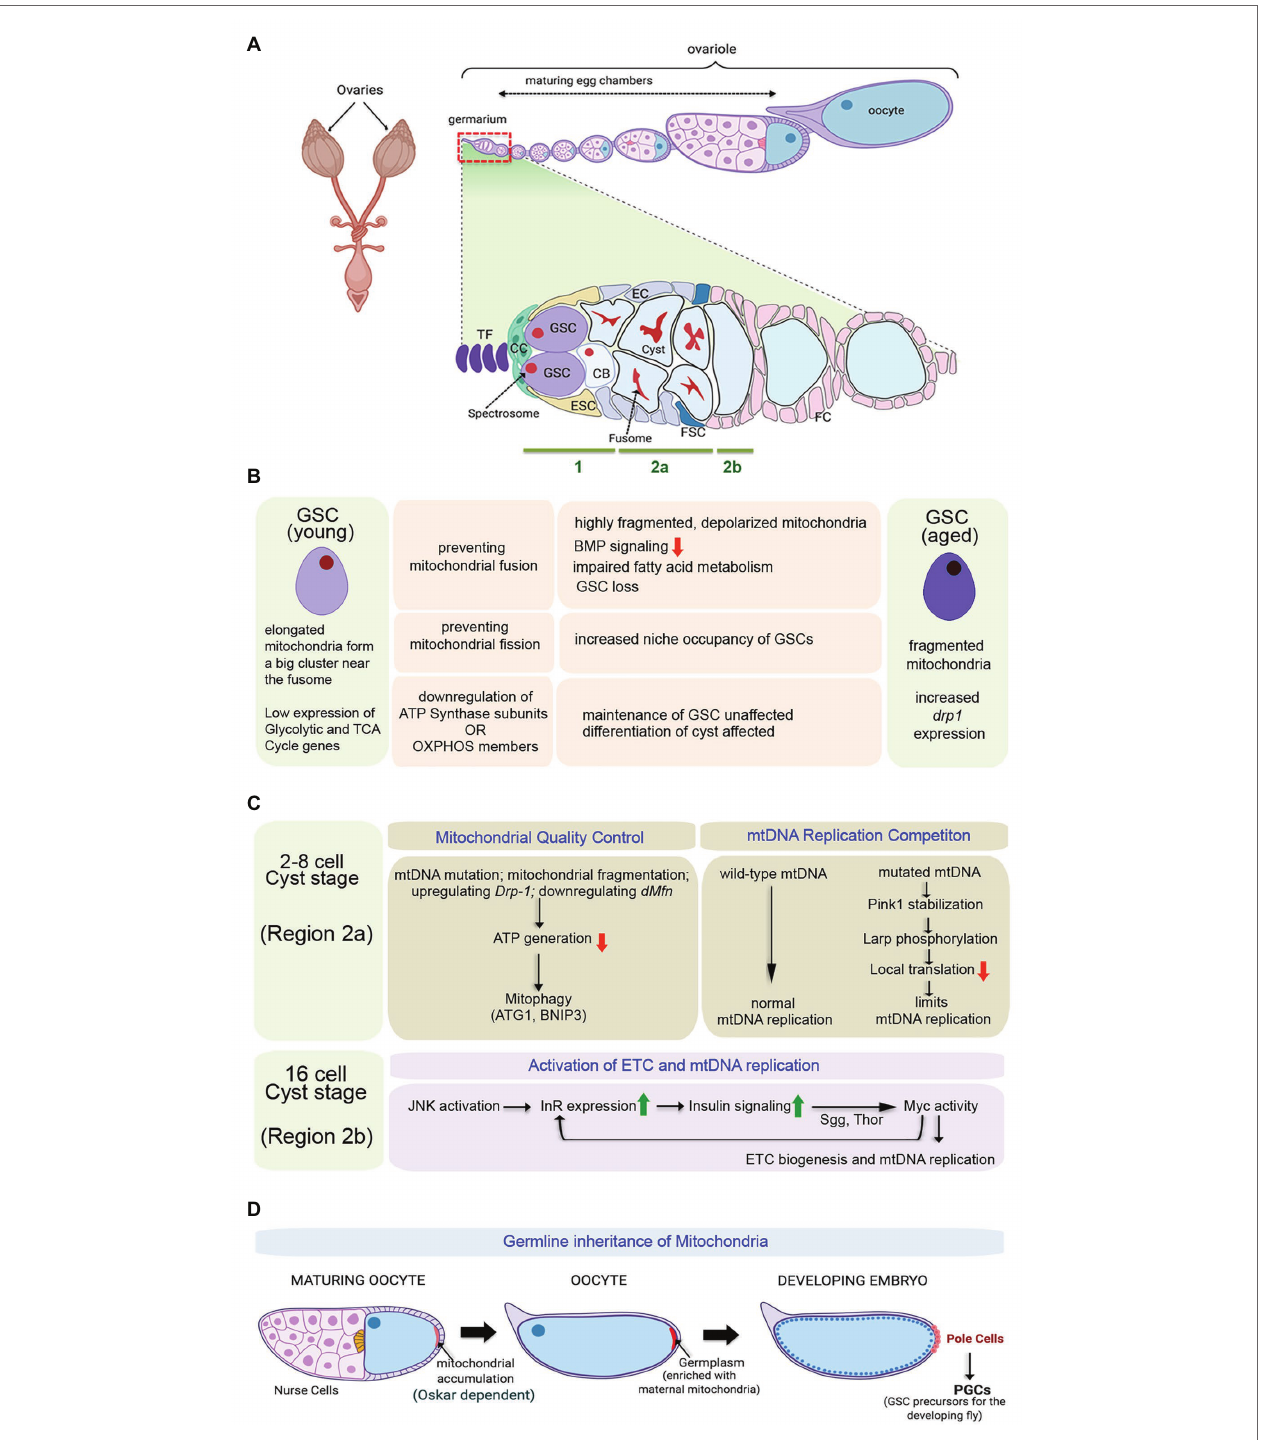
FIGURE 2 | Importance of mitochondria in governing proliferation and differentiation of female GSCs in Drosophila . (A) Schematic representation of the adult ovary, a single ovariole showing the relative position of the germarium and the developing egg chambers, and a magnified view of the germarium displaying the anatomical position of the female GSCs, niche components, Escort Stem cells (ESCs), and Follicle Stem Cells (FSCs). The expanded forms of the acronyms used are provided in the text. (B) Table showing the diverse outcomes of manipulating mitochondrial structure and function in the young female GSCs. While young GSCs have elongated mitochondria, the aged ones are characterized by fragmented mitochondria. (C) Schematics of the pathways involved in mitochondrial quality control, mitochondrial DNA (mtDNA) replication competition, and activation of electron transport chain (ETC) and mtDNA replication in the developing cysts. (D) Diagrammatic representation of the process of germline inheritance of mitochondria through the pole